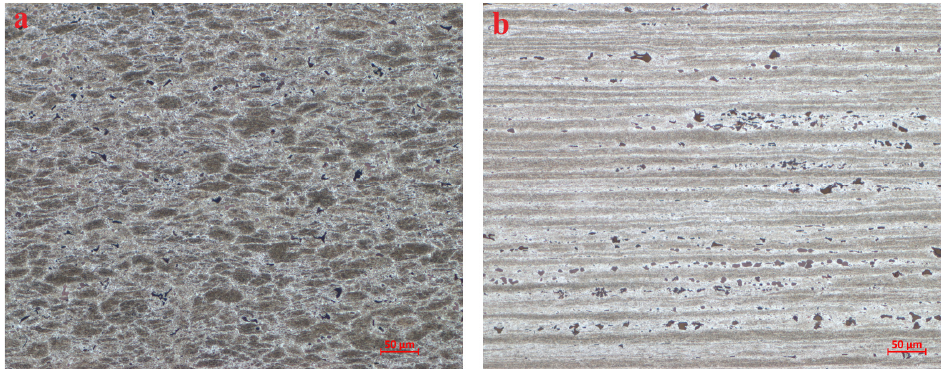
Figure 13. Extrusion pipe. ( a ) 35 MN extruding machine; ( b ) 2A12 pipe.